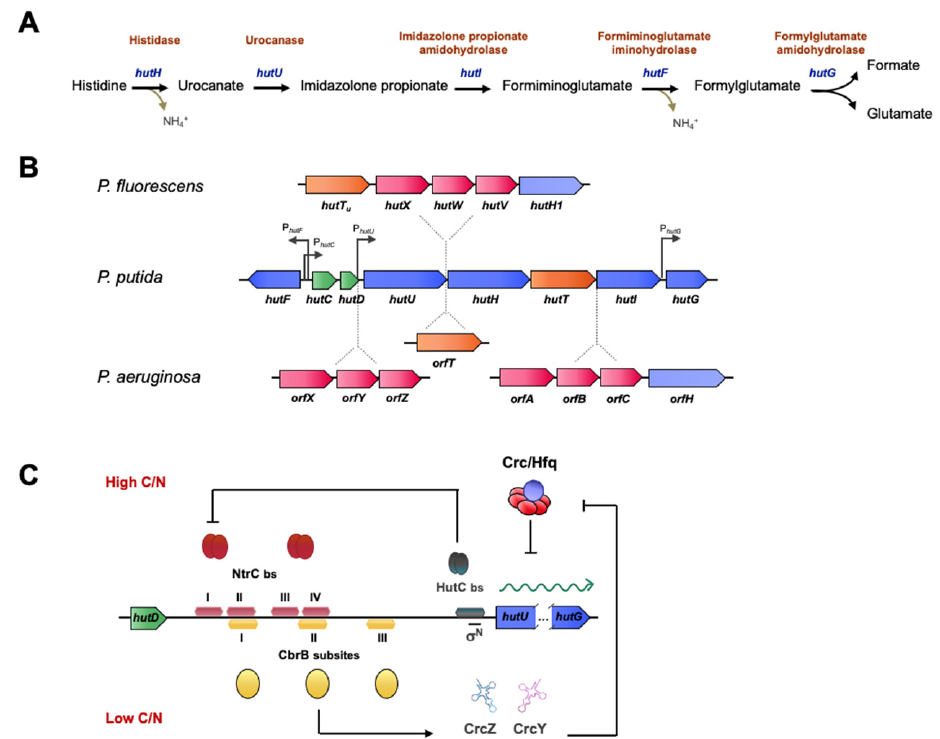
Figure 4. ( A ) Conserved histidine catabolic pathway in Pseudomonas , that yields 2 moles of ammonia, 1 mole of glutamate, and 1 mole of formate per mole of histidine. Genes coding for each activity are denoted in blue and the enzymes in brown. ( B ) Genetic organization of the hut operons in three Pseudomonas species ( P. fluorescens , P. putida and P. aeruginosa ). Genes with the same colors are homologous (catabolic enzymes in blue; histidine transporters in orange; ABC-type transporters in pink; other hut genes in green). ( C ) Carbon and nitrogen regulation of the hut genes by CbrAB, NtrC, Crc/Hfq and HutC regulators. In high-carbon-availability conditions, NtrC activates the catabolism of histidine, and HutC slows down the production of ammonia, which inhibits the process. Crc/Hfq represses the translation of the hut mRNAs in these conditions. At low C concentrations, CbrB is active and binds the promoter region of hutU . The sRNAs CrcZ and CrcY are highly activated by CbrB and sequester the Crc/Hfq complex, which is inactivated, thus promoting the translation of hut transcripts. The control of the hut pathway is a central model for the study of gene regulation in several families. In particular, in pseudomonads, it coordinates processes of carbon and nitrogen metabolism and catabolic repression, as well as temperature-dependent regula- tion [109]. The regulators involved in these processes are HutC, CbrB, and NtrC. All three bind to the intergenic region between hutCD and hutU , at the operator sites of hut promoters that share binding sequences, resulting in steric hindrance in the regulatory